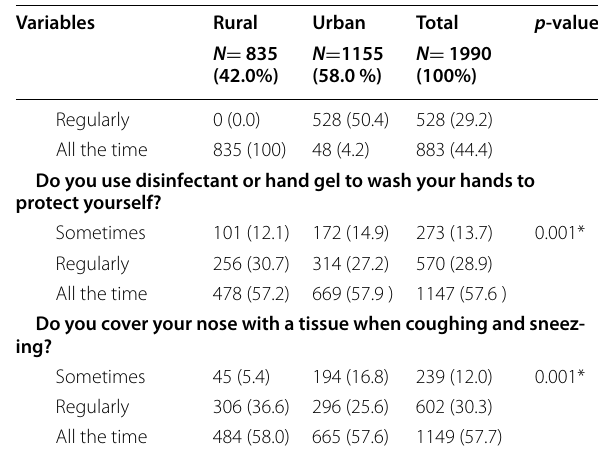
Table 3 Participant’s attitudes and practices toward the